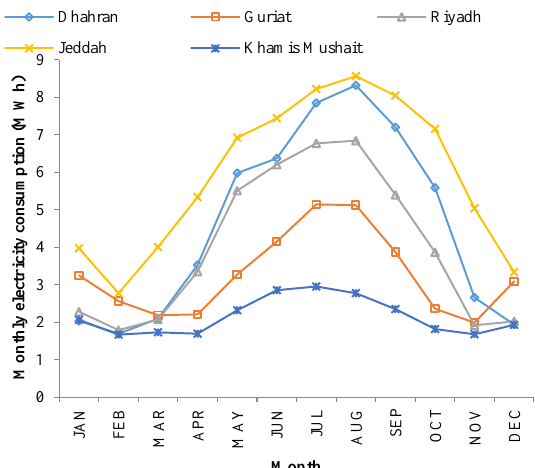
Figure 10. Monthly electricity consumption for the base house based on the optimum orientation in the five climatic zones.